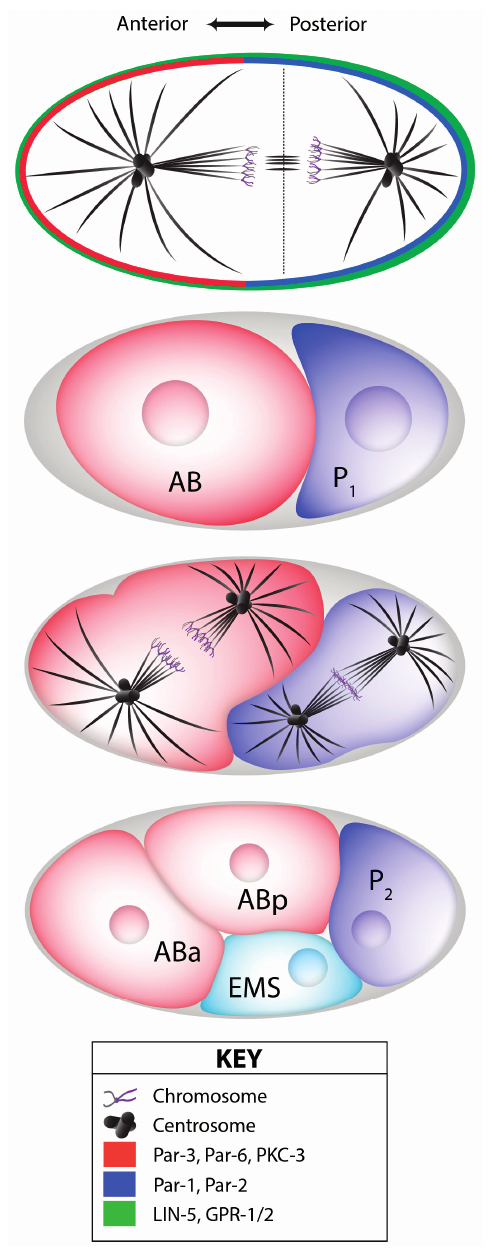
Figure 1. Oriented cell division in the C. elegans zygote. The first zygotic division in C. elegans proceeds asymmetrically to generate differential AB and P1 cells. Par proteins in the zygote are polarized along an anterior-posterior cortical axis: the anteriorally-localized Par-3/Par-6/aPKC ( red ) and posteriorally-localized Par-1/Par-2 ( blue ) complexes mutually repress cortical localization of one another. Spindle orientation along this polarity axis is regulated by the GPR-1/2 and LIN-5 complex (which is enriched at the posterior cortex), ensuring proper asymmetry in polarity protein distribution in daughter cells. This complex also induces a physical, posterior displacement of the spindle apparatus relative to the cell center, thereby generating a size asymmetry in offspring. Spindles in the resulting AB and P1 cells rotate relative to the original zygotic axis in subsequent divisions, yielding further diversification at the four-cell stage. These cells ultimately lead to the production of distinct cell lineages and their associated tissue structures in the developing animal